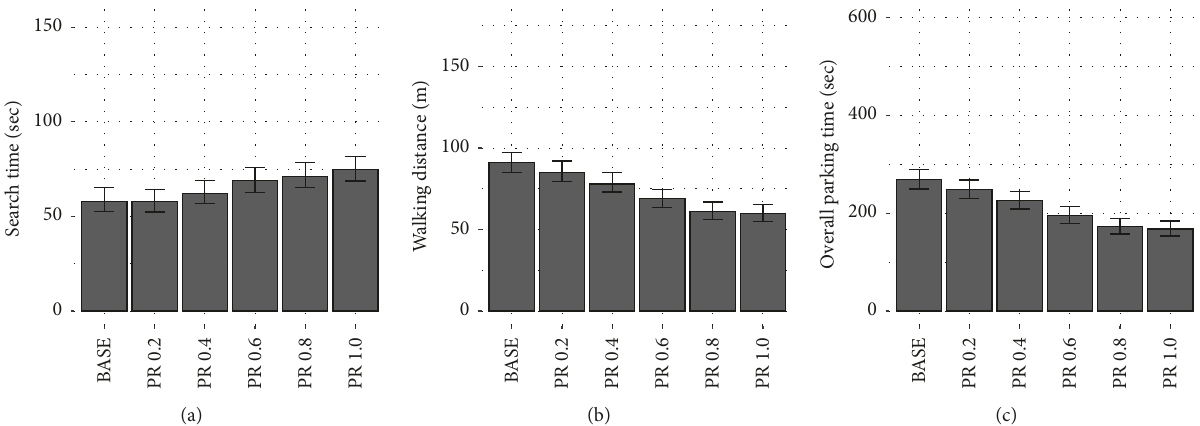
Figure 5: Results at the system level for on-street parking: (a) search time, (b) walking distance, and (c) total parking time, for regular cars and smart cars, for a 95% confidence interval at afternoon peak